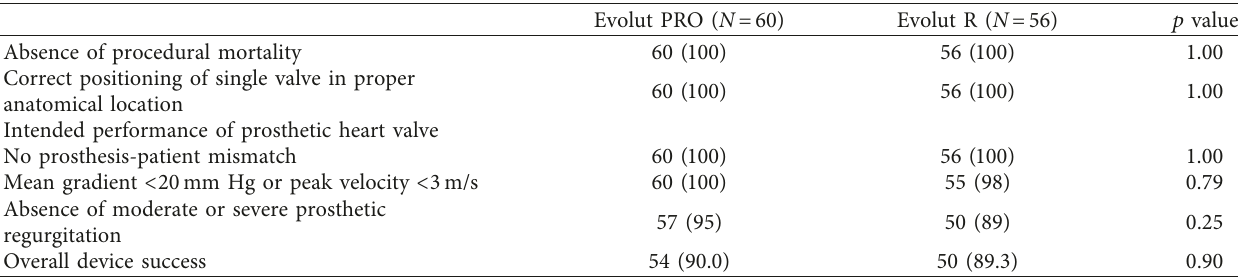
Table 3: Device success at